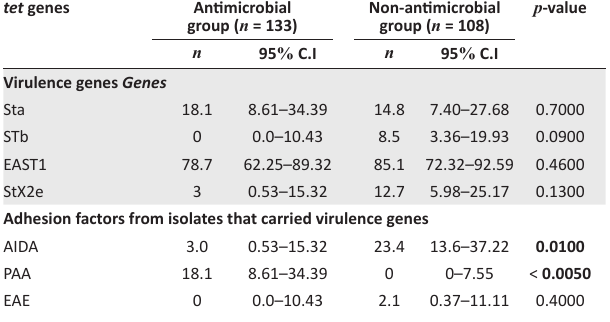
TABLE 3b: Frequency of Escherichia coli isolates, virulence genes, adhesion factors and pathotypes from Escherichia coli isolates with virulence genes. tet genes Antimicrobial group ( n = 133)